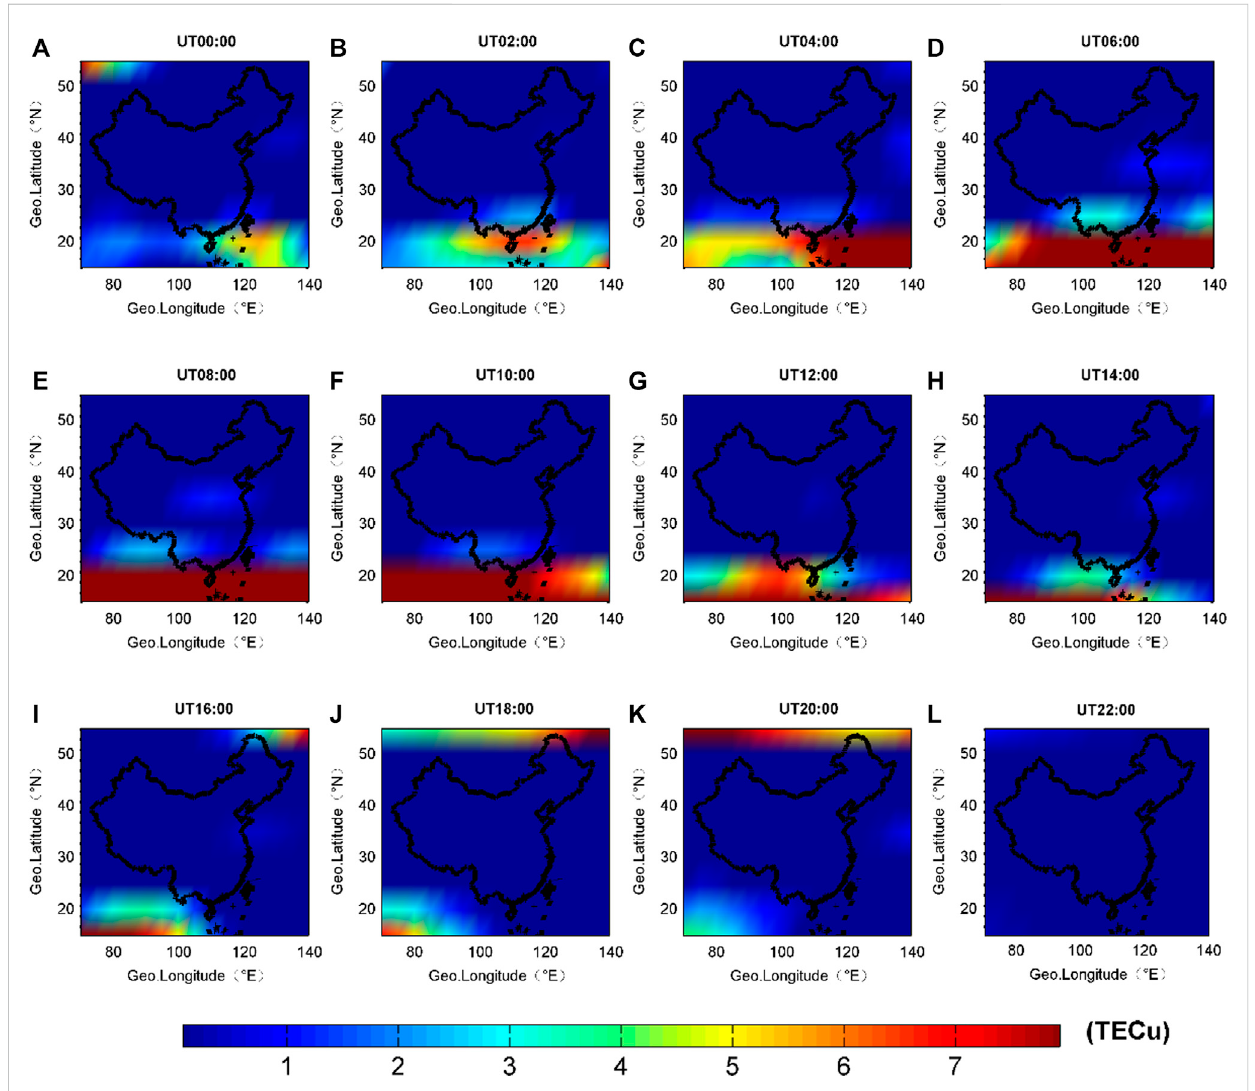
FIGURE 5 The spatial distributionaverage bias ofthe difference between IGS GIM and RIM, the x -axis and y -axis denote geographic longitude and geographic latitude, respectively. The color scale indicates the magnitude of TEC in TECu.